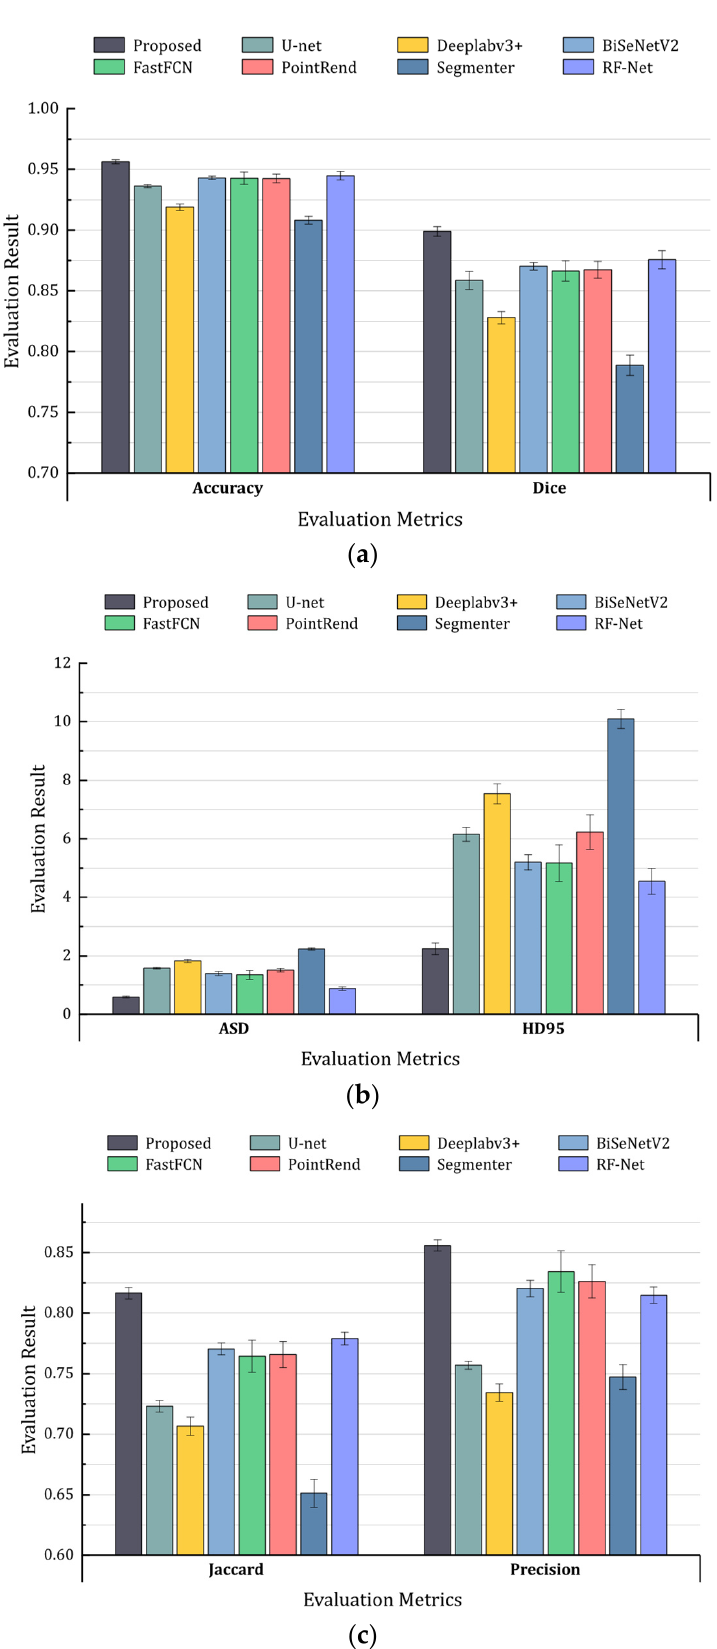
Figure 6. Column chart for comparison results. ( a ): Accuracy and dice score; ( b ): ASD and HD95; ( c ): Jaccard score and Precision.